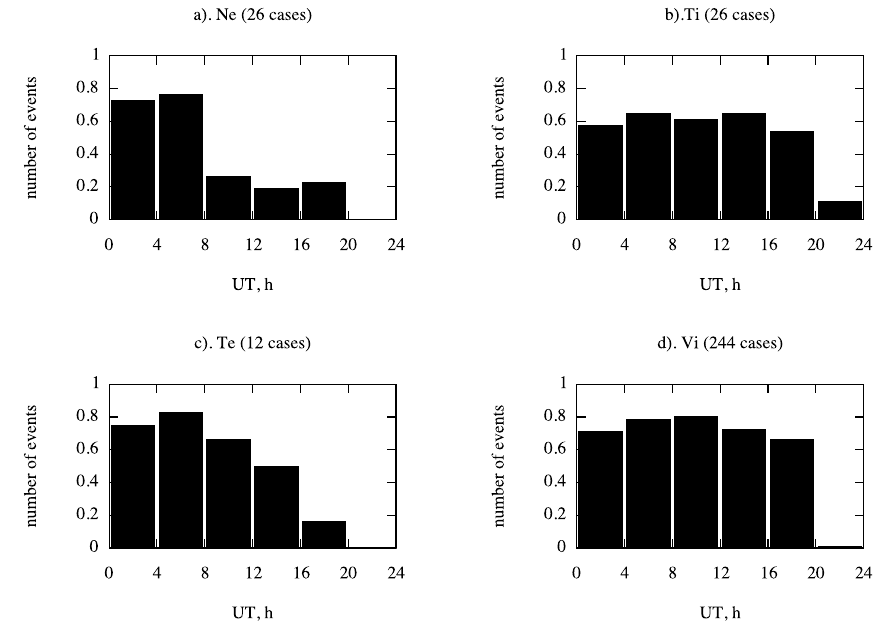
Fig. 13. AGW-TID occurrence rate as a function of UT for the all the four ISR